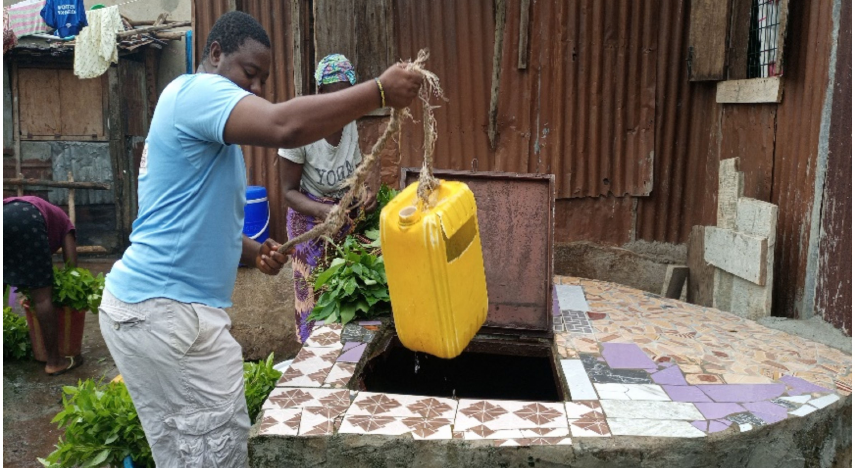
Figure 4. Sources of contamination at a well. Leafy vegetables are washed on top of the well, and that same water may drain back into the well. While the woman washes the vegetables, the man fetches water using a plastic container hung from a rope. The lid or cover is also prone to corrosion as it is made of iron and can be another potential source of contamination.